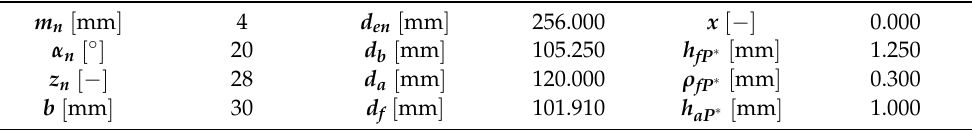
Table 5. Gear data relative to the 4 mm-module gear.